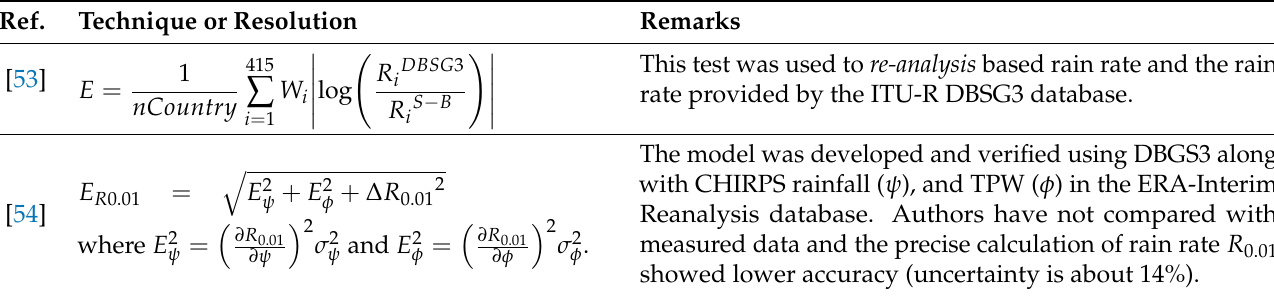
Table 4. Error estimation techniques for rain rate